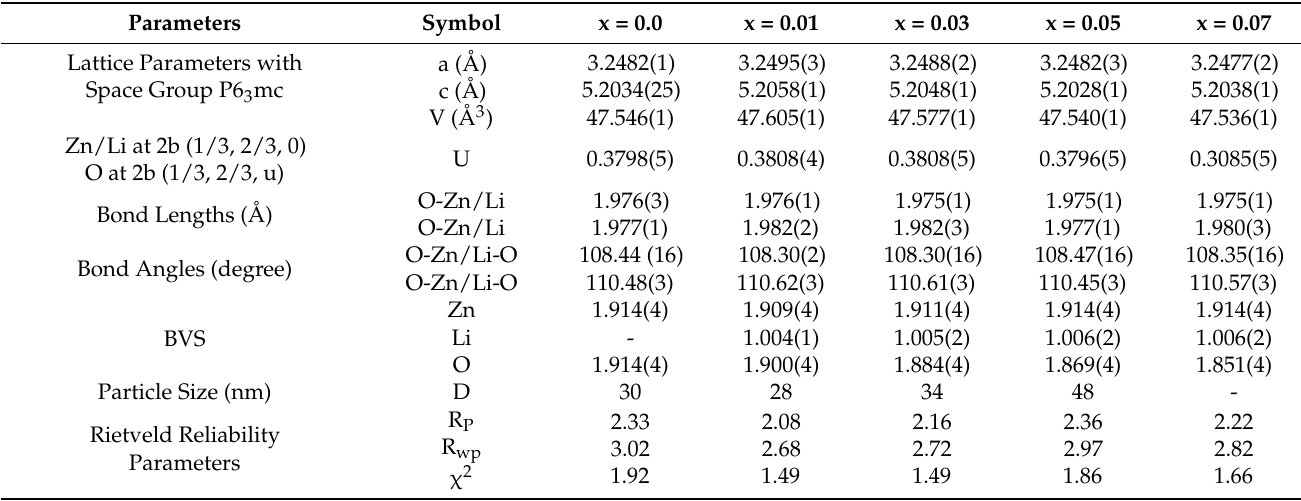
Table 1. By using Rietveld refinement to the XRD patterns, the crystal structural characteristics of Zn 1 − x Li x O nanoparticles were